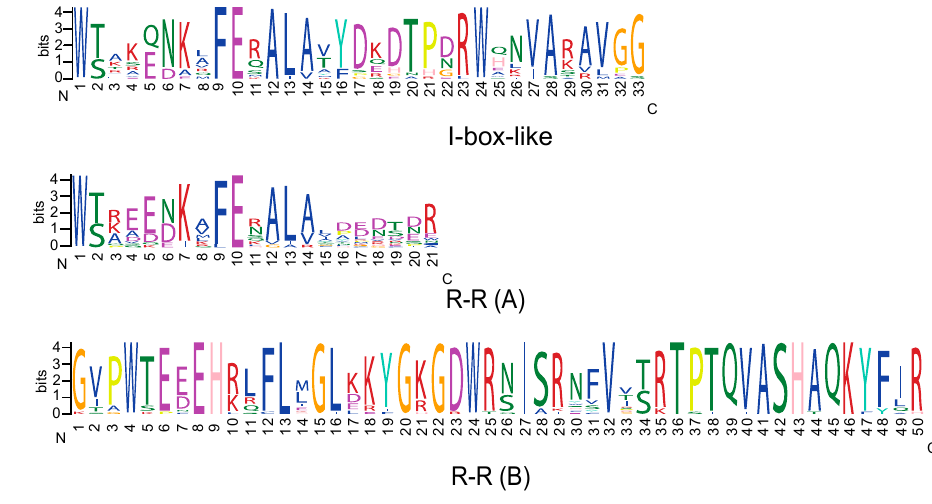
Figure 5. Motif analyses of I-box -like and R-R -type genes of the MYB family. One motif was identified for the I-box -like genes and two motifs, i.e., R-R ( A ) and R-R ( B ), were found for the R-R -type genes. The x-axis indicates the sequence of the amino acids from the N- to C- terminal for each motif; the y-axis provides the information at each position in the motif; and the highly conserved positions in the motif show a large proportion of the bits for a particular amino acid.